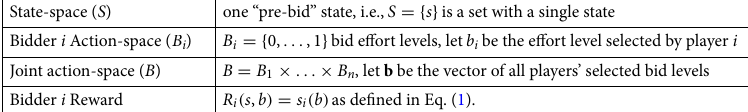
Table 4. All-pay auction as a multi-agent reinforcement learning problem.